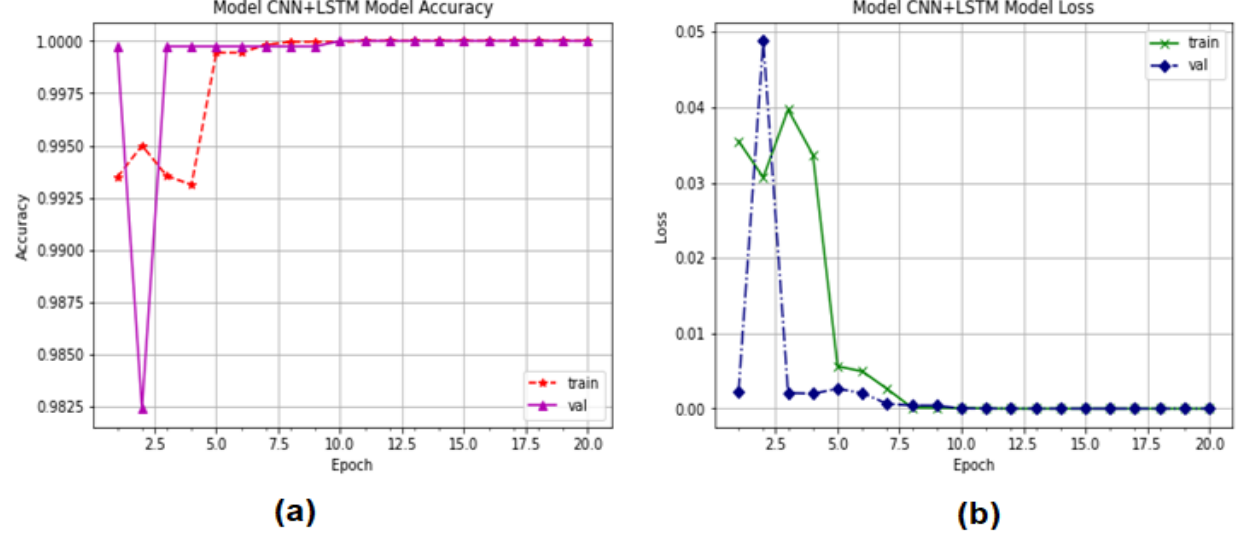
Figure 9. The CNN–LSTM model’s performance for detection of attacks on Agriculture 4.0. ( a ) Model accuracy ( b ) Model loss.